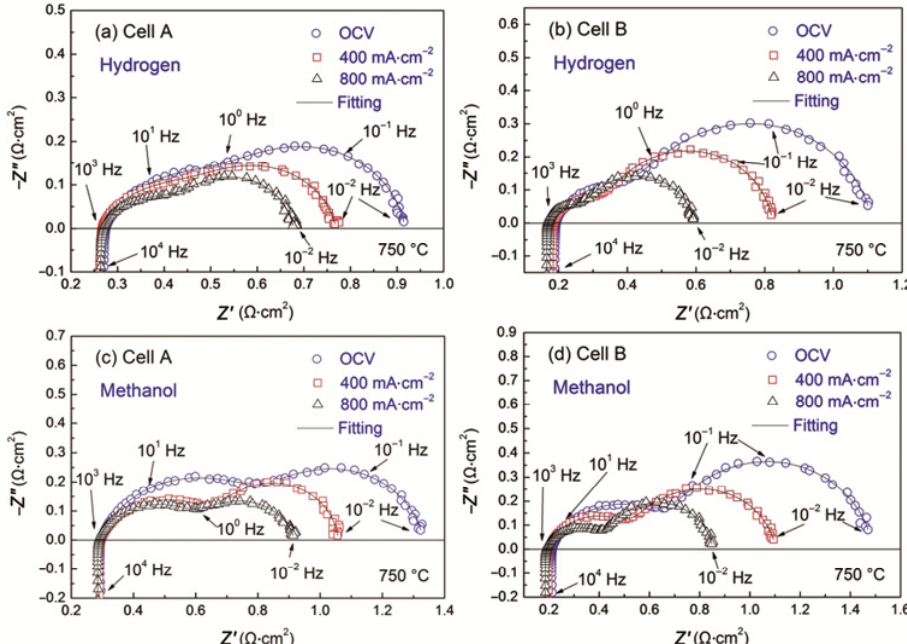
Fig. 7 Nyquist plots of single cells in hydrogen and methanol under different discharging current density: (a, c) anode- supported single cell with a thin catalyst layer and (b, d) anode-supported single cell with an independent catalyst